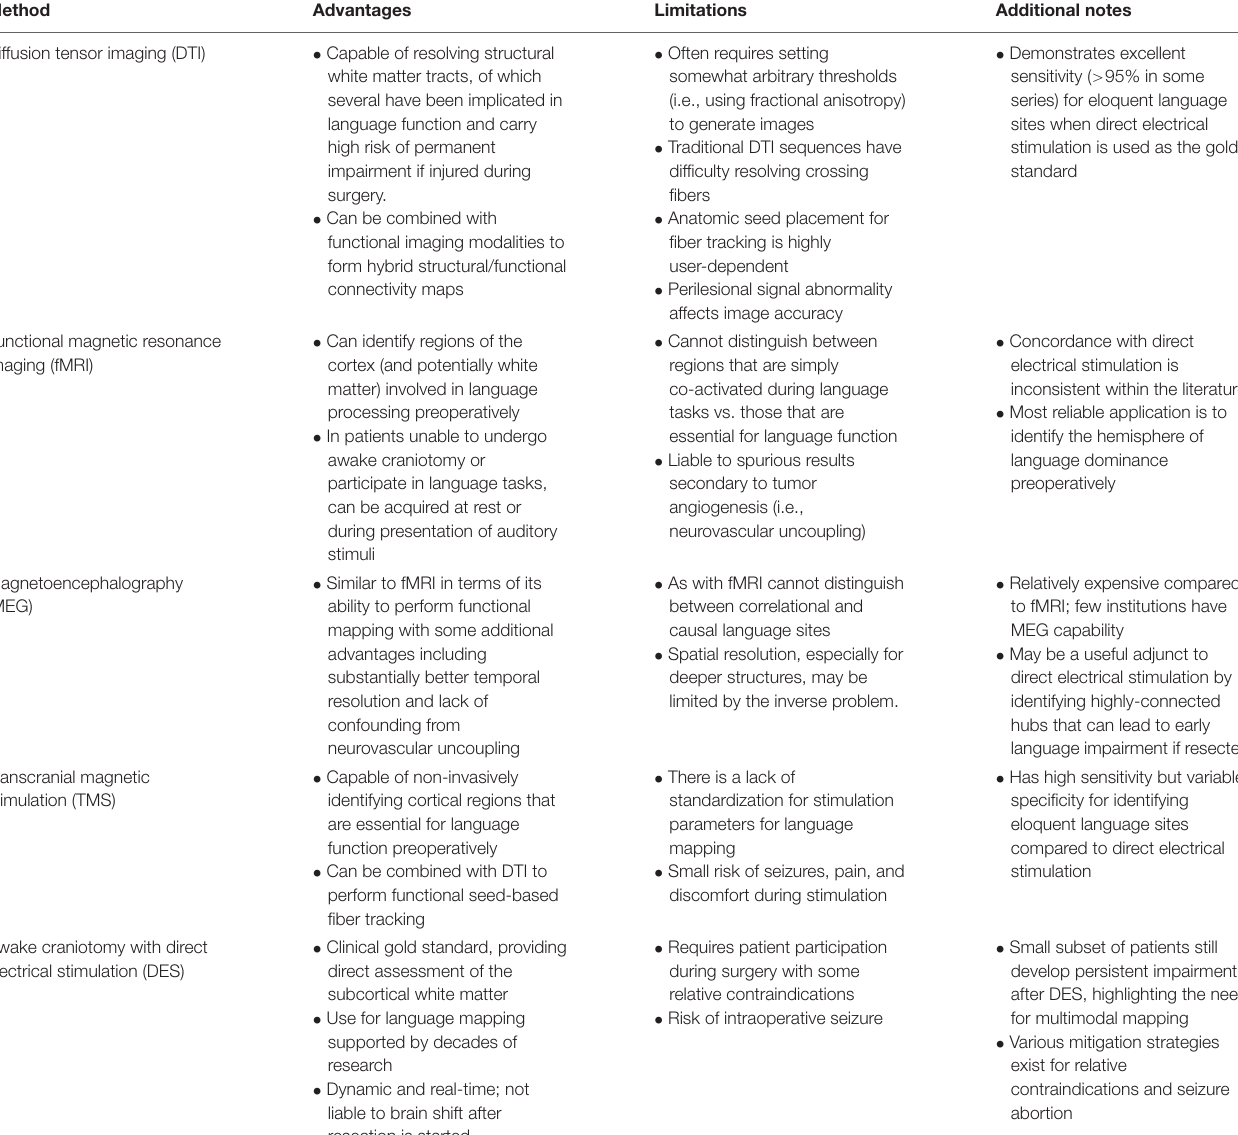
TABLE 1 | Summary of techniques used to map white matter language tracts in patients with